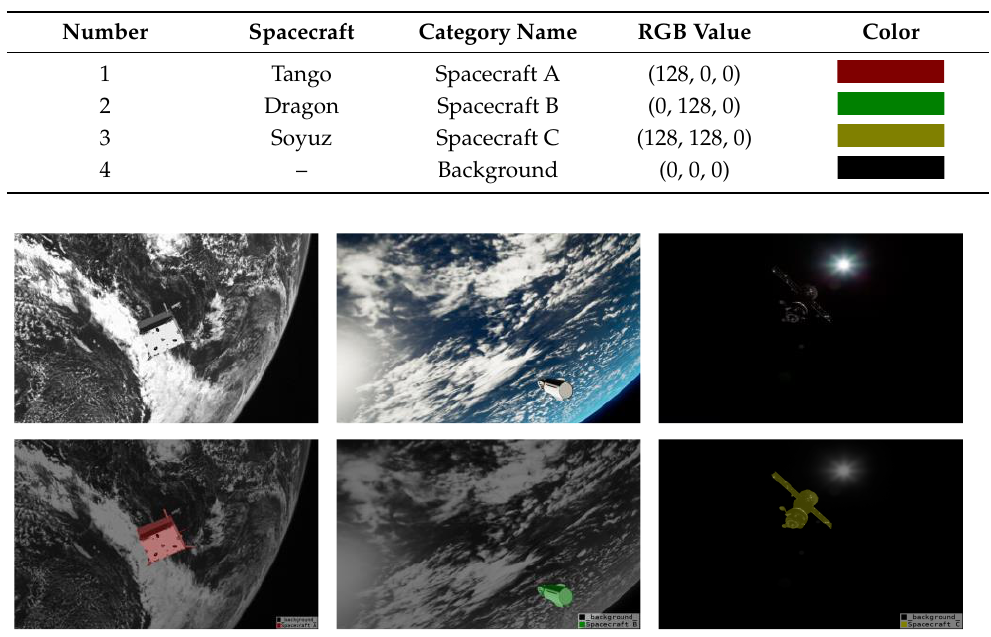
Table 2. Classification number, name, and color table.